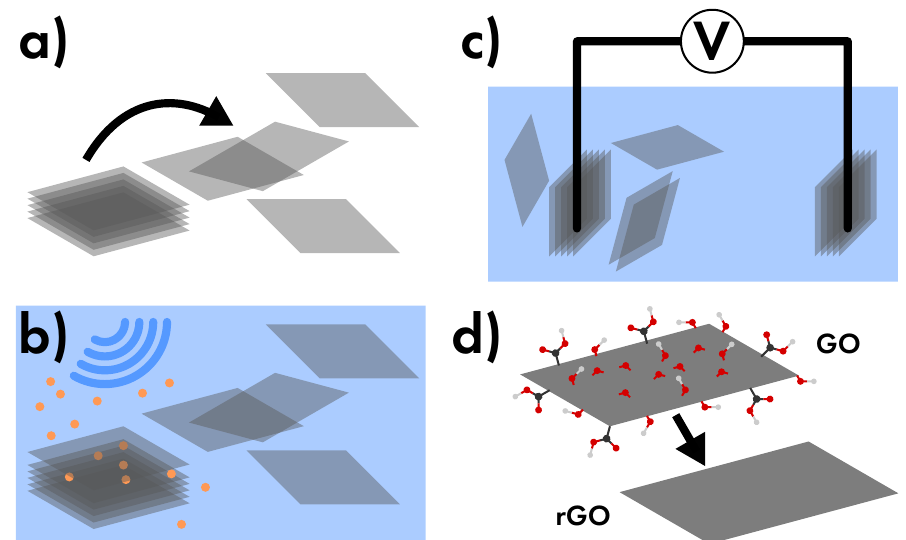
Figure 28. Representative depiction of graphene produced by ( a ) mechanical exfoliation, ( b ) liquid-phase exfoliation, ( c ) electrochemical exfoliation, and ( d ) reduced graphene oxide (rGO) obtained from graphene oxide